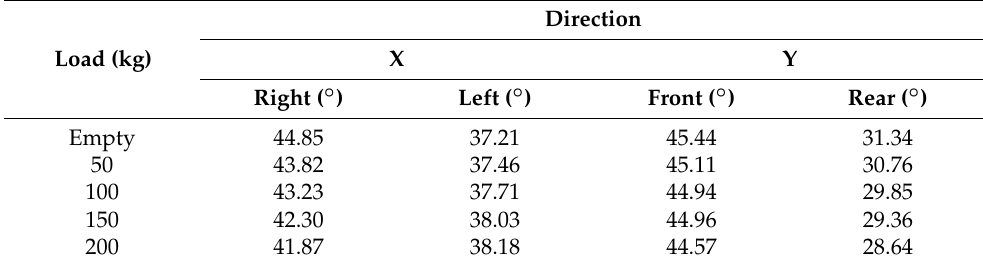
Table 4. Overturning angle of the